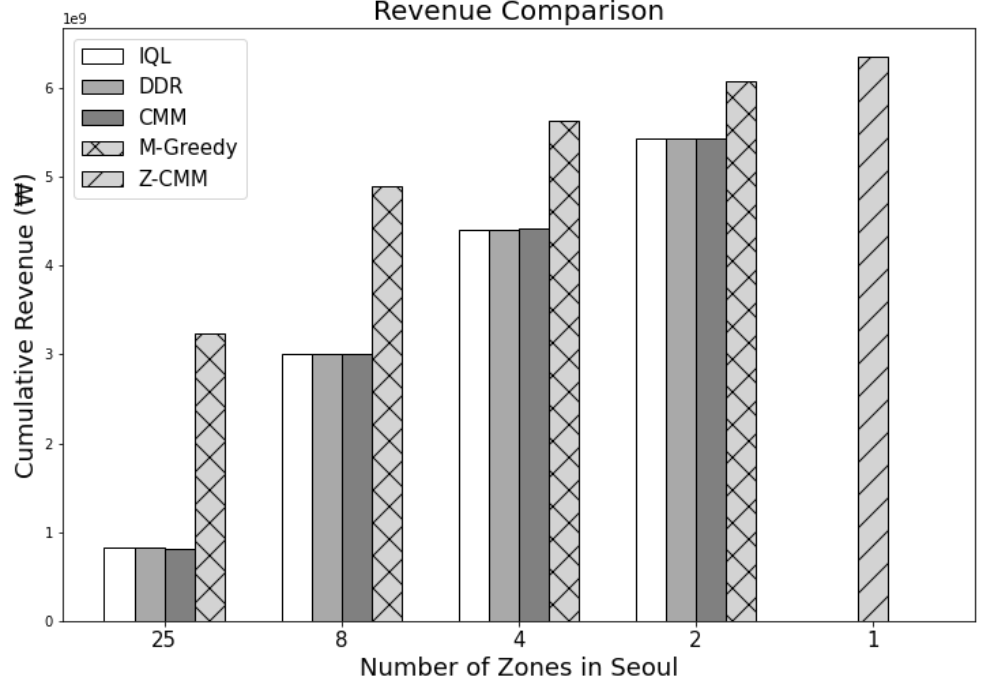
Figure 11. Comparison of the cumulative revenue by each methodology during 24 h. The Z-CMM methodology recorded the highest revenue among the